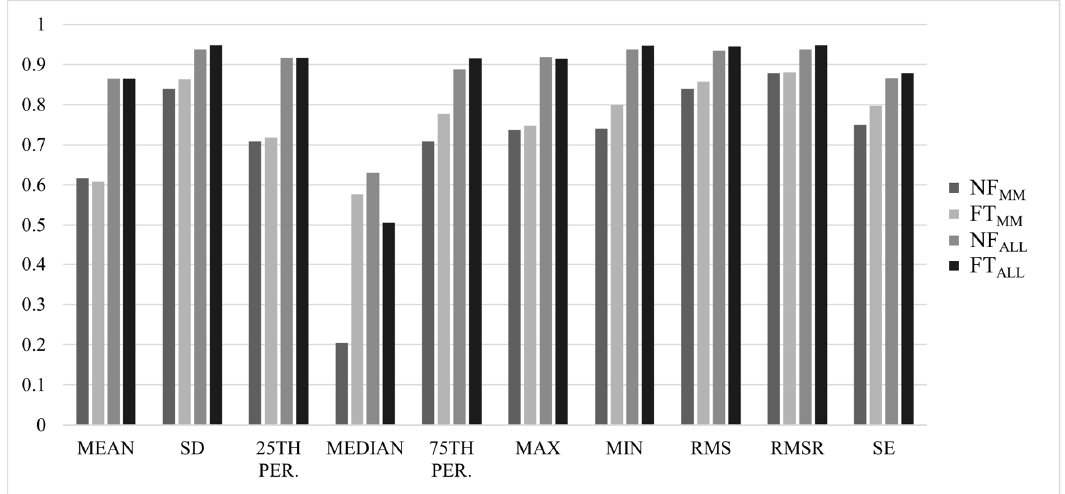
Figure 2. ICC(2,k) values for all analyses in the mediolateral (ML) axis of the acceleration signal.